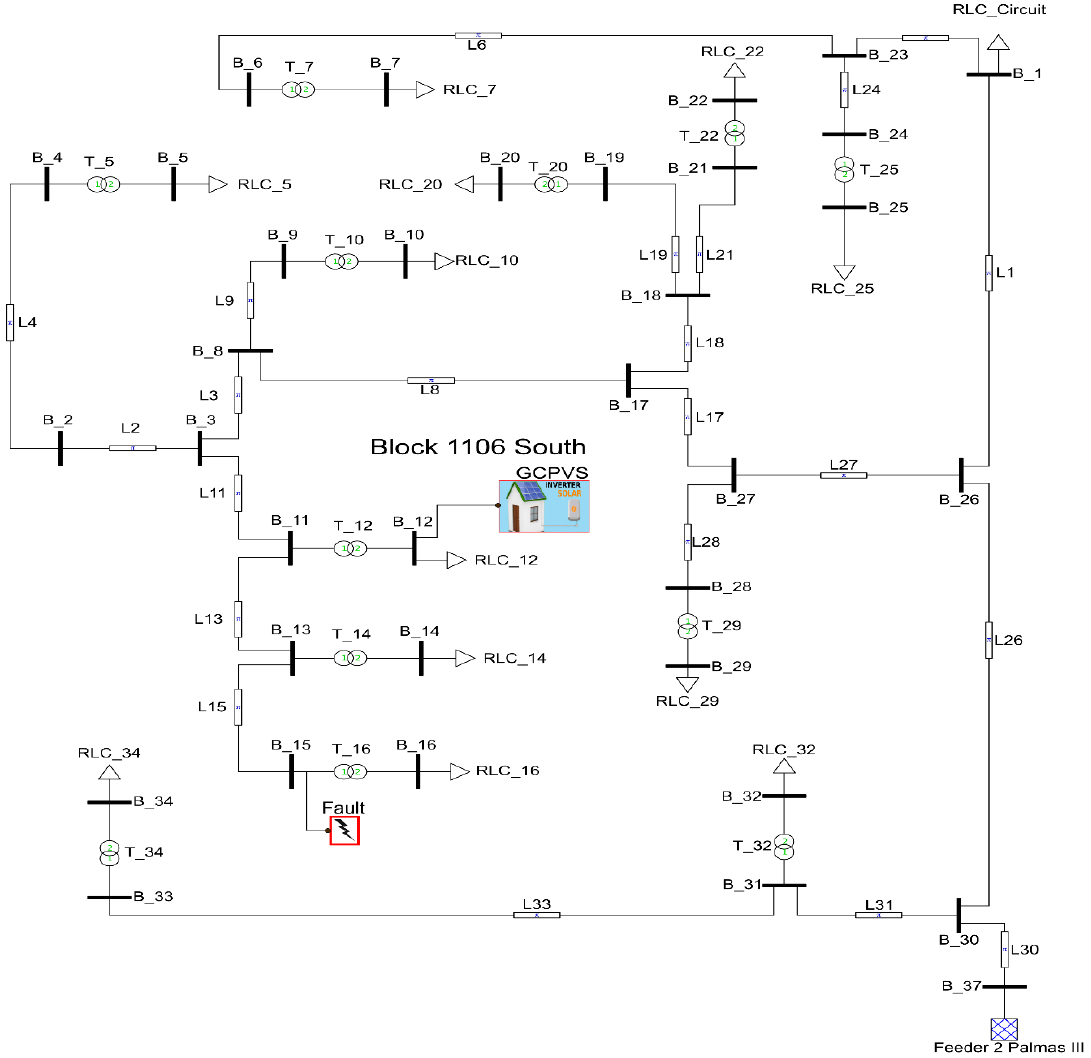
Figure 6. Single-line diagram of the real grid modeled in Matlab/Simulink ® . Table 2. Data from the transformers connected to the 1106 South court distribution grid [31], Table 2 presents the transformers data, while Table 3 presents the secondary of each transformer and the number of consumer units connected to it. A constant power load (RLC) represents this number. Table 4 refers to data and parameters of the lines between the primary transformers and the substation (radial topology connection model). These data were provided by the local electric power utility for the block 1106 South distribution grid.